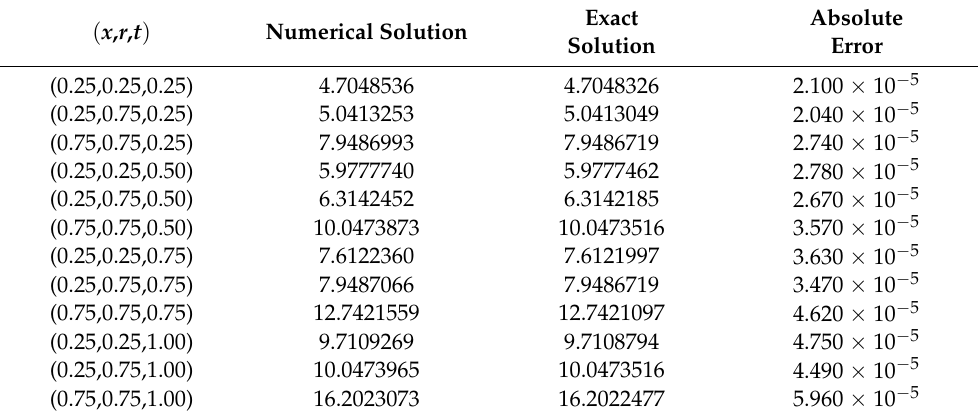
Table 3. Numerical solution, exact solution, and absolute error at some nodes ( h = 1 / 32, τ = 1 / 64 ) .